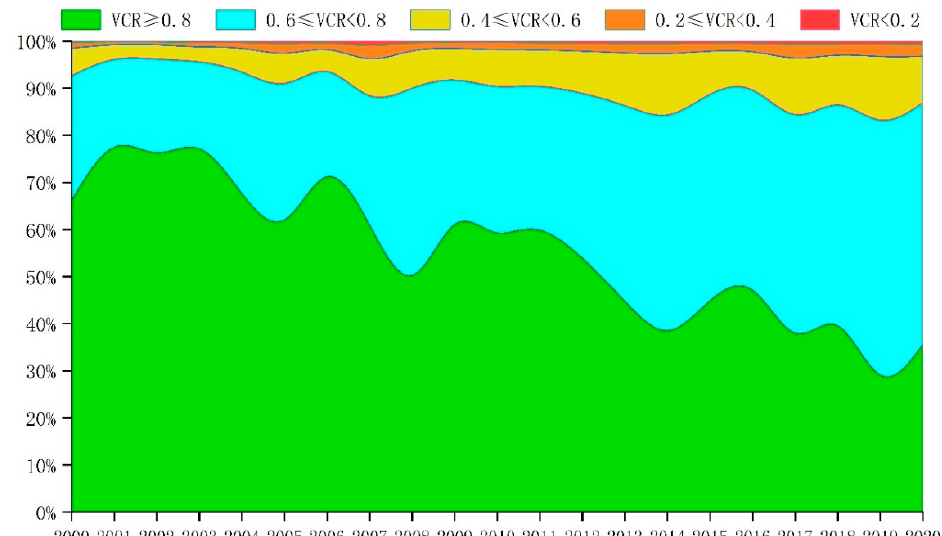
Figure 9. Area ratio of different vegetation coverage rates from 2000 to 2020.